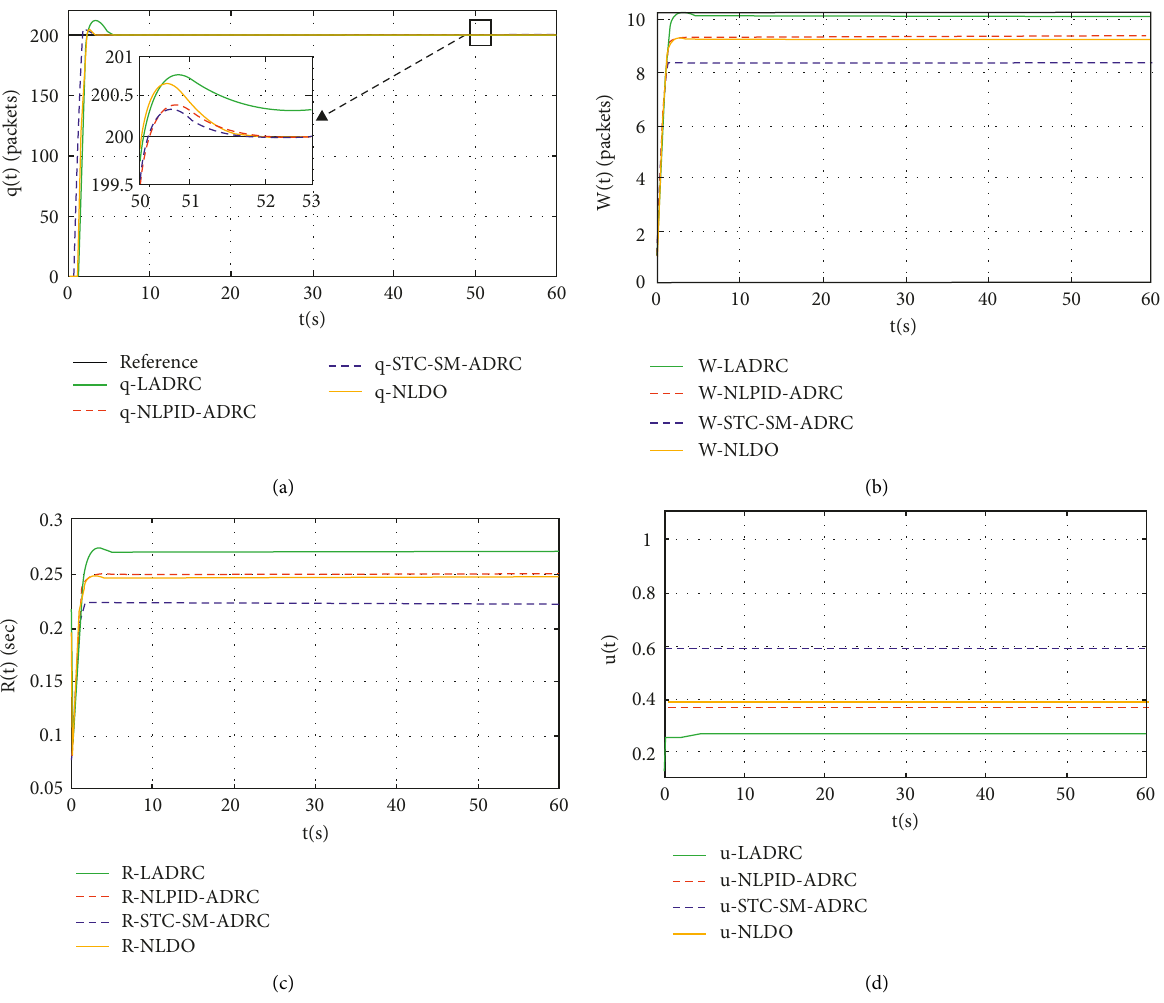
Figure 6: The output response when the disturbance is applied at t � 50s. (a) The average queuing length q ( t ) . (b) The window size W ( t ) . (c) The round trip time R ( t ) (d). The probability of losing packets u ( t )